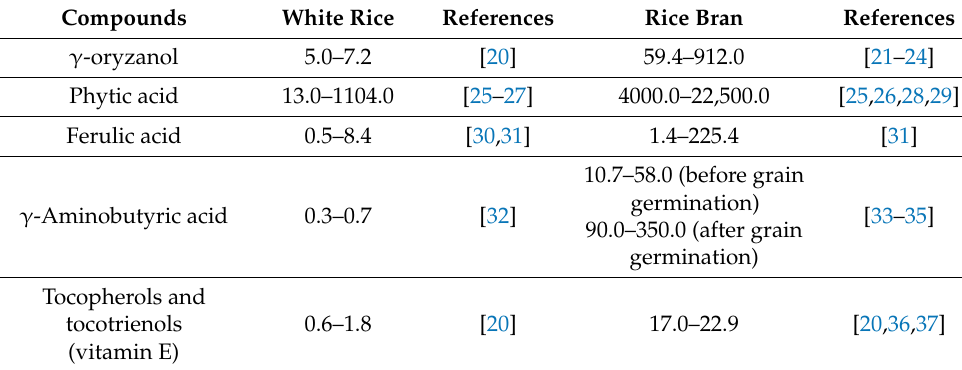
Table 2. Main bioactive compounds in white rice and rice bran (mg/100